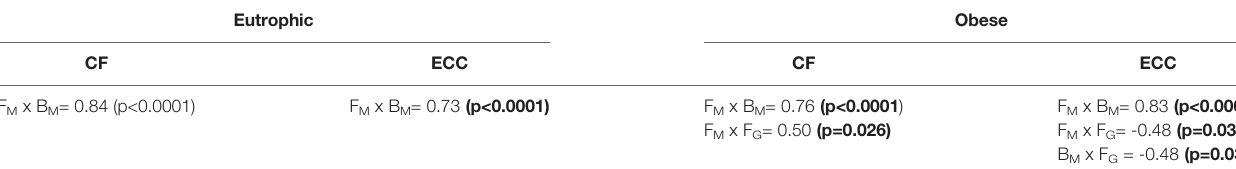
TABLE 2 | Pearson ’ s correlation models for obese and eutrophic children according to their ECC status. Eutrophic